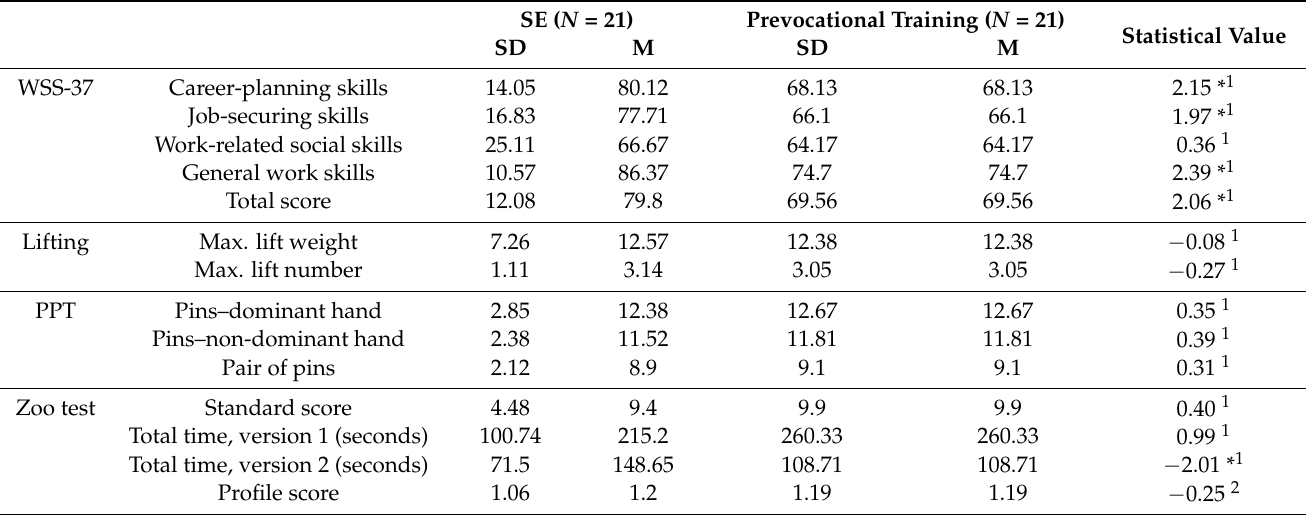
Table 3. Work-related self-efficacy, cognitive skills, and motor skills among working and non-working participants.